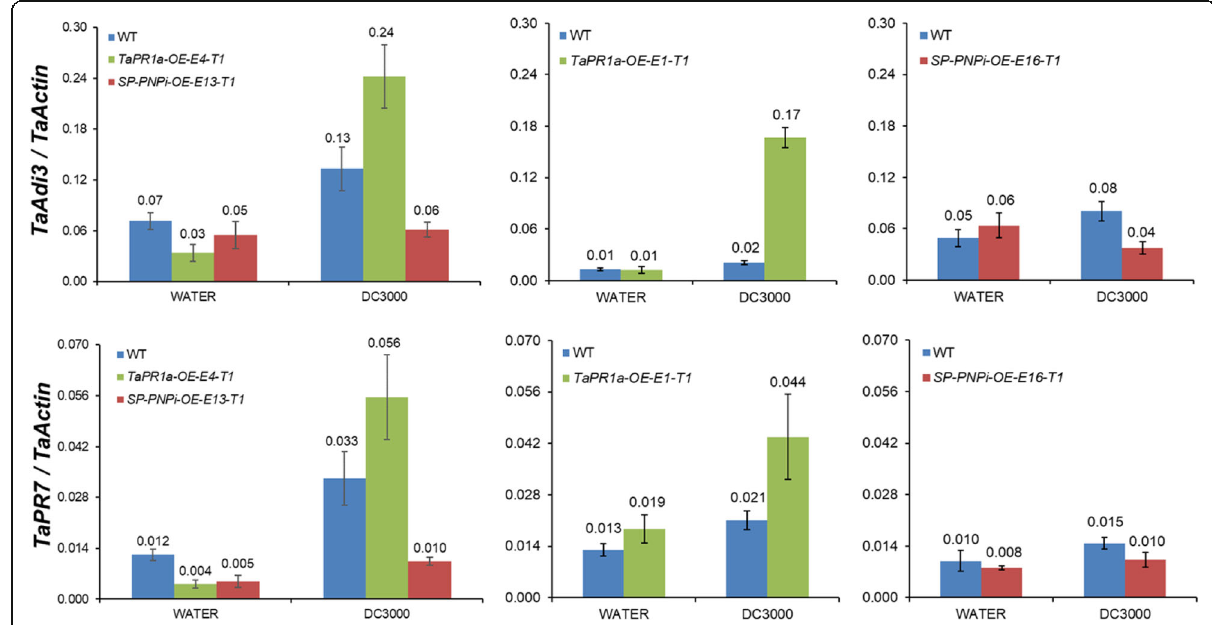
Fig. 6 The transcriptional levels of TaAdi3 and TaPR7 were determined by RT-qPCR in transgenic wheat lines TaPR1a-OE and SP-PNPi-OE upon P. syringae DC3000 infection. Two independent transgenic lines of TaPR1a-OE and SP-PNPi-OE were tested. Statistical analyses are presented in Additional file 1: Table